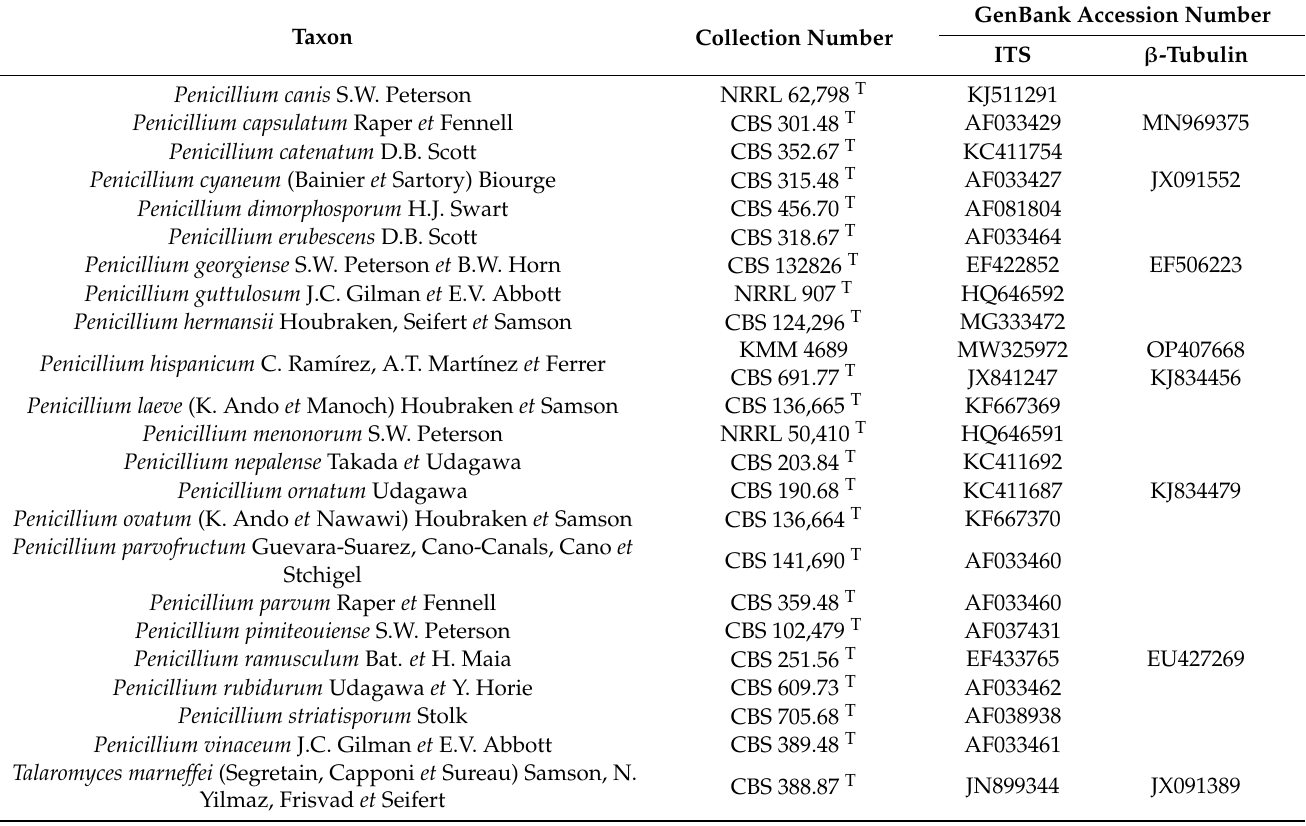
Table 2. Strains used in phylogenetic analysis and GenBank accession numbers of ITS and β